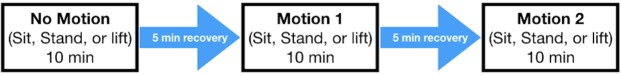
Experimental design schematic.Participants perform a task (i.e., quiet sitting on a chair, standing in an upright position, or lifting and lowering a load) for each of the three motion conditions. Each session (NM, LM, HM) began with quiet sitting while resting metabolic rate (RMR) was collected. Exposure to each motion condition lasted 10 min with a minimum of a 5-min rest period between conditions. The no motion trial was always presented to the participant first.